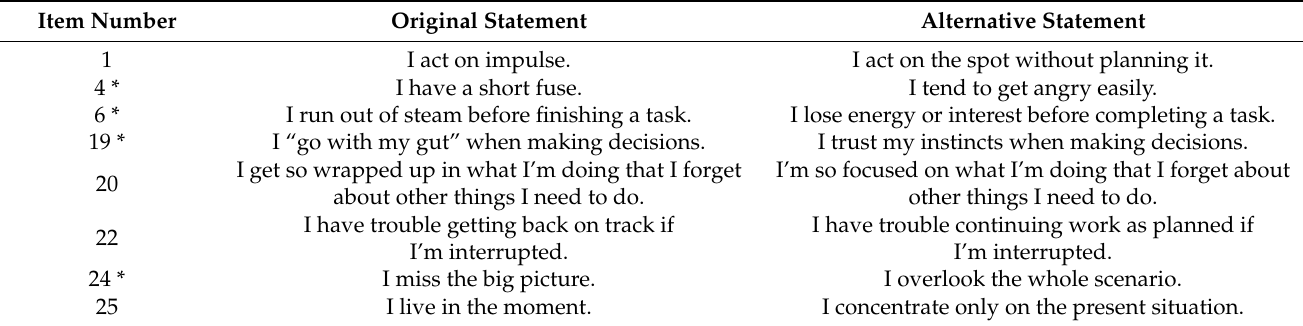
Table 1. Alternative Statements for the Selected Executive Skills